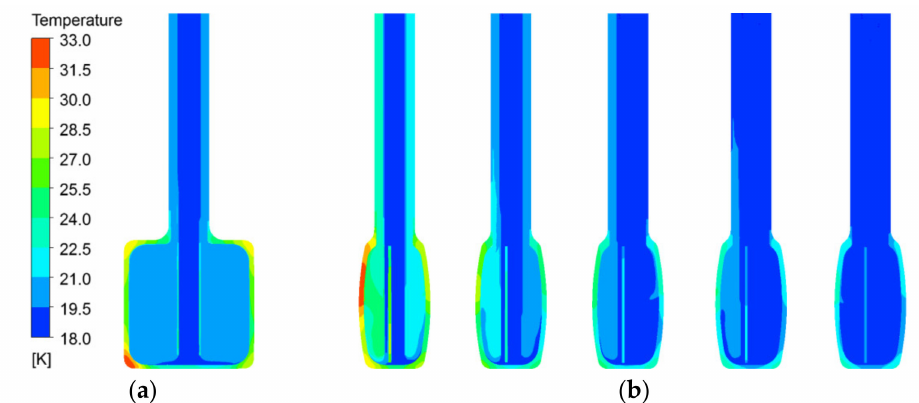
Figure 9. Temperature distribution of DPHM (beam power = 500 kW): ( a ) x = 0 mm (60 g/s); ( b ) y = 0 mm (30, 60, 90, 120, 150 g/s).